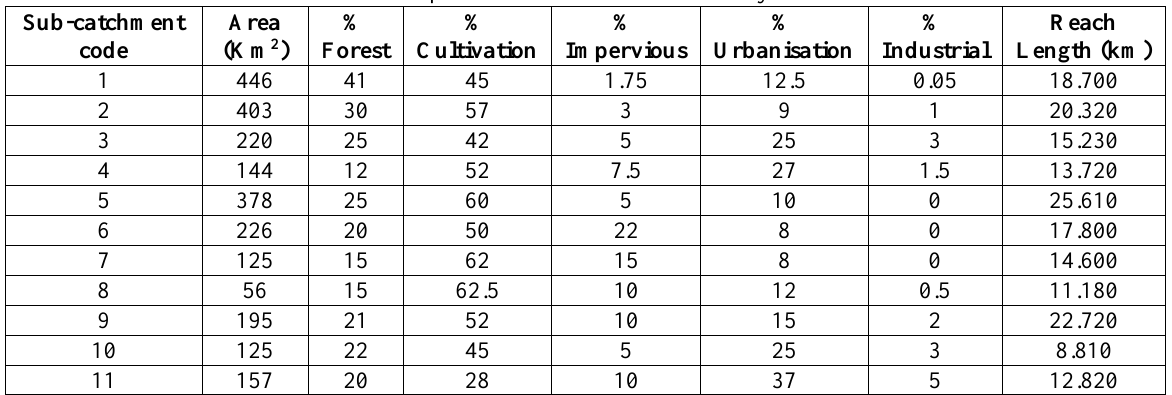
Table 1: Descriptive information of LULC for hydraulic load.